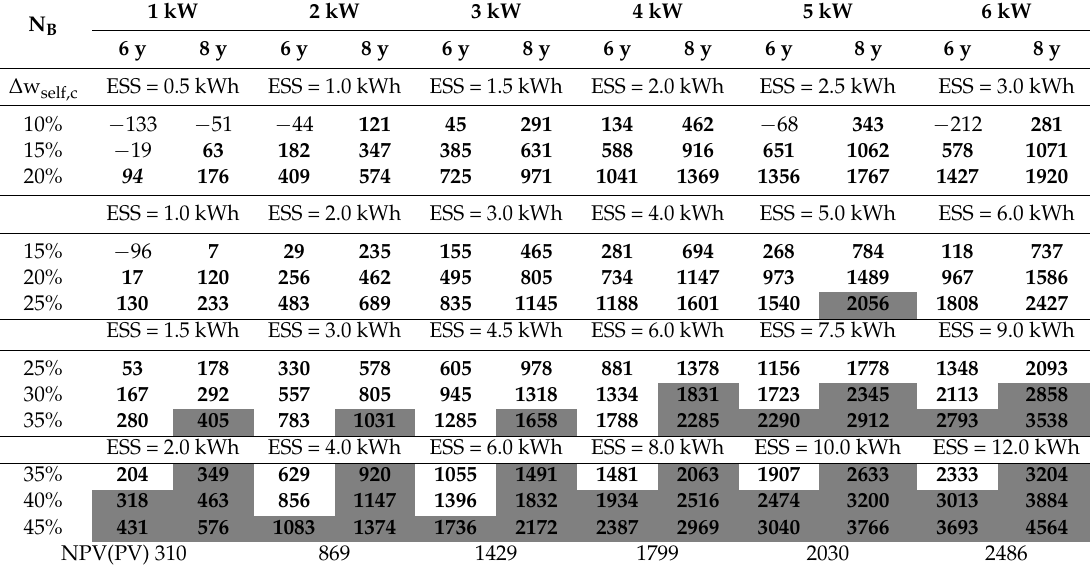
Table 7. Net Present Value ( € ) of integrated PV-battery systems with redefined regional